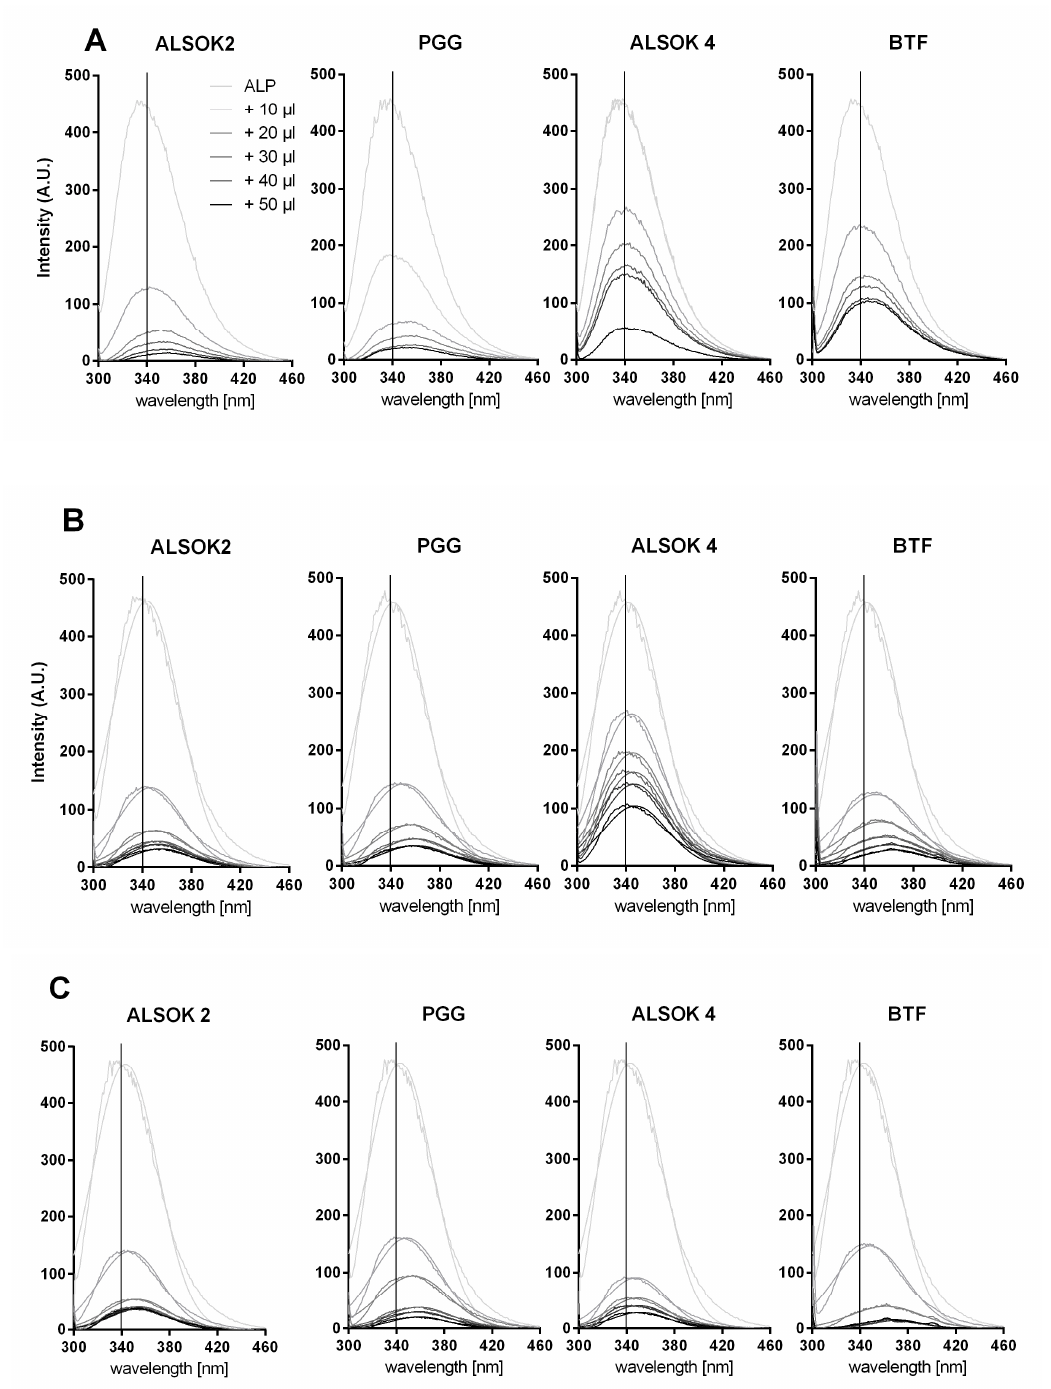
Figure 3. ( A ) Fluorescence emission spectra between 300 and 460 nm at 294 nm extinction of alkaline phosphatase (ALP) in water with increasing concentrations of gallotannins dissolved in dimethyl sulfoxide (DMSO). ( B ) Spectra between 300 and 460 nm with excitation at 294 nm of ALP + CaCl 2 , with increasing concentrations of tannins. ( C ) Spectra between 300 and 40 nm with excitation at 294 nm of ALP + CaCl 2 + gellan gum (GG), with increasing concentrations of gallotannins. The vertical line at 340 nm was added to facilitate optical comparison of the different spectra.